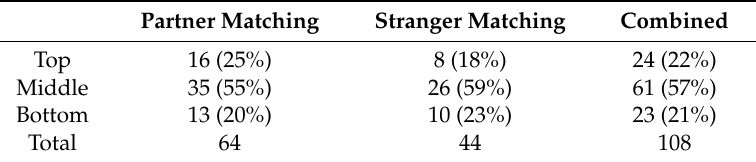
Table 5. Classification of subjects into types based on Round 1 beliefs. Partner Matching